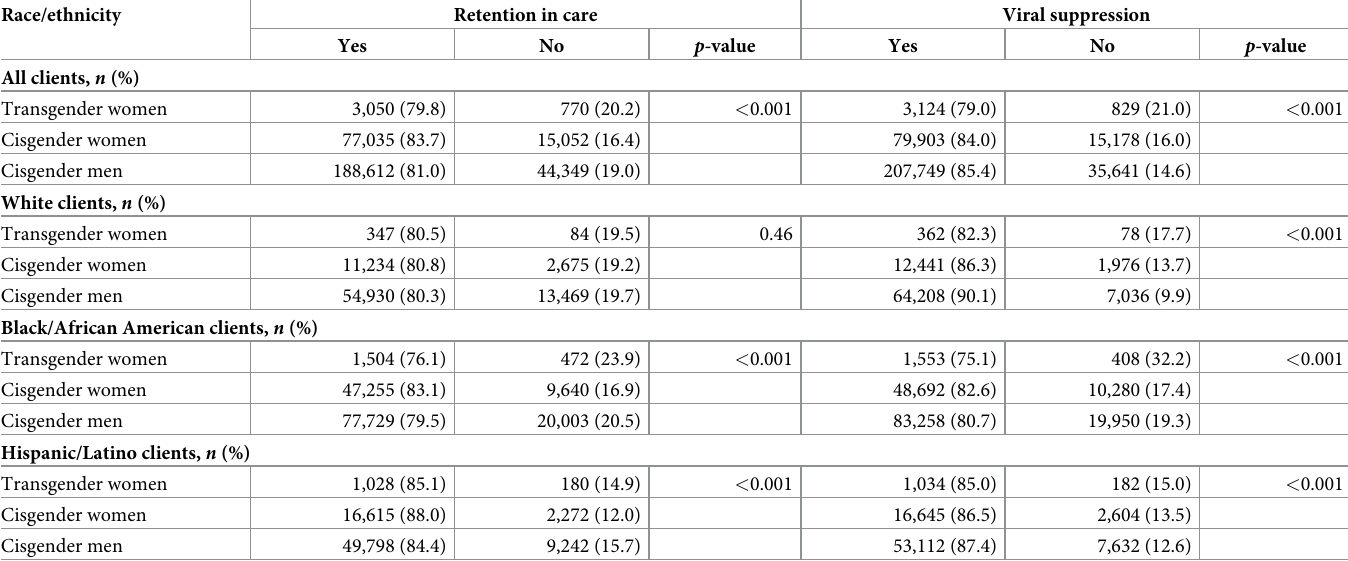
Table 3. Retention in care and viral suppression among transgender women, cisgender women, and cisgender men served by the HRSA RWHAP, by race/ethnicity, 2016. Race/ethnicity Retention in care Viral suppression All clients, n (%)